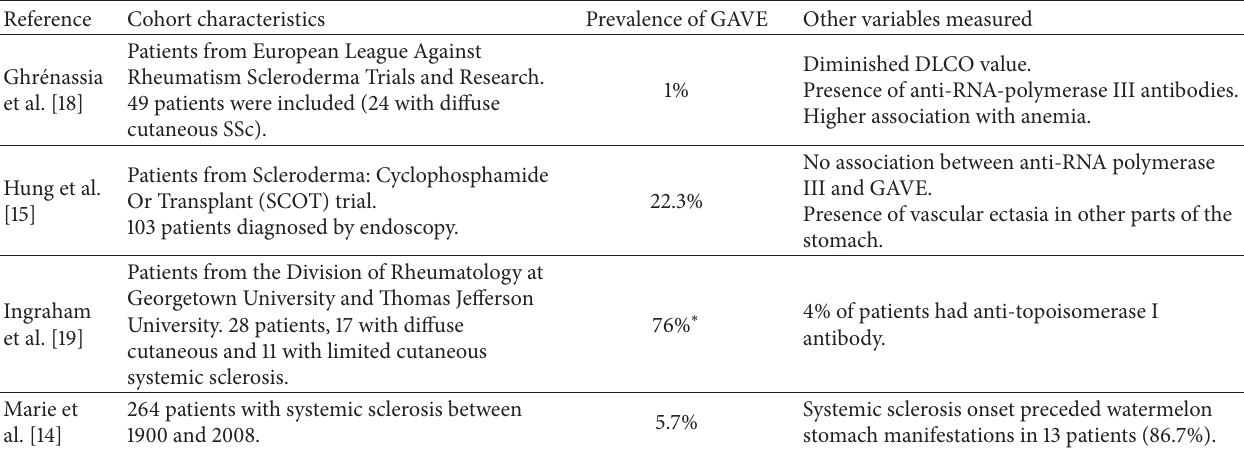
Table 1: Prevalence of GAVE in patients with systemic sclerosis.